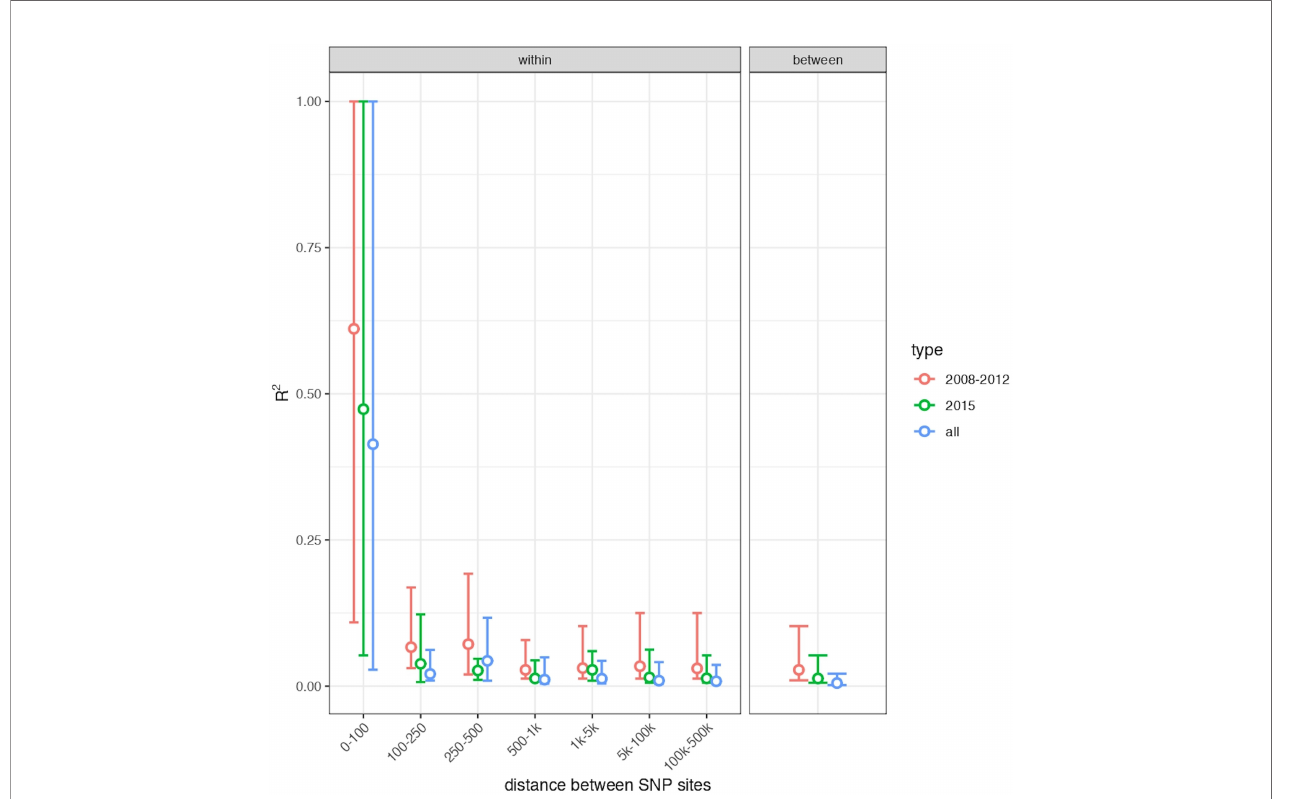
FIGURE 5 | Linkage disequilibrium decay with genomic distance. Points show the median and bars show the interquartile range of R 2 for all pairs of SNP variants within each category of physical distance on the genome for SNPs on the same chromosome (left panel) and for all pairs of SNPs on different chromosomes (right panel). Values are shown separately for Governador Valadares samples from 2008/2012, Governador Valadares samples from 2015 and both groups together, in each case including only SNPs that vary within the relevant group of samples. The absolute values of R 2 are affected by the number of samples in a group, but all sets show a similar, rapid decay in linkage disequilibrium, suggesting frequent recombination within each group.